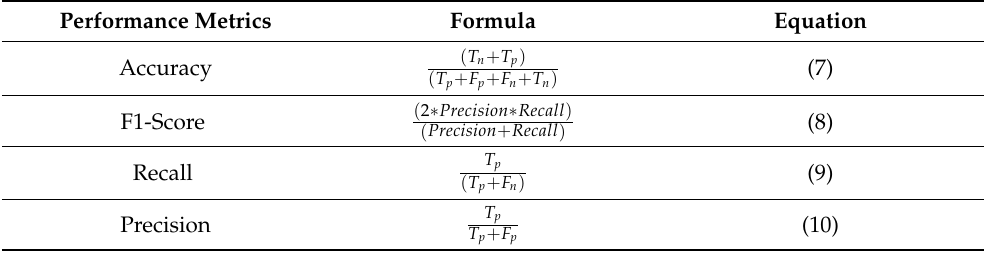
Table 5. Performance metrics and their formulas.